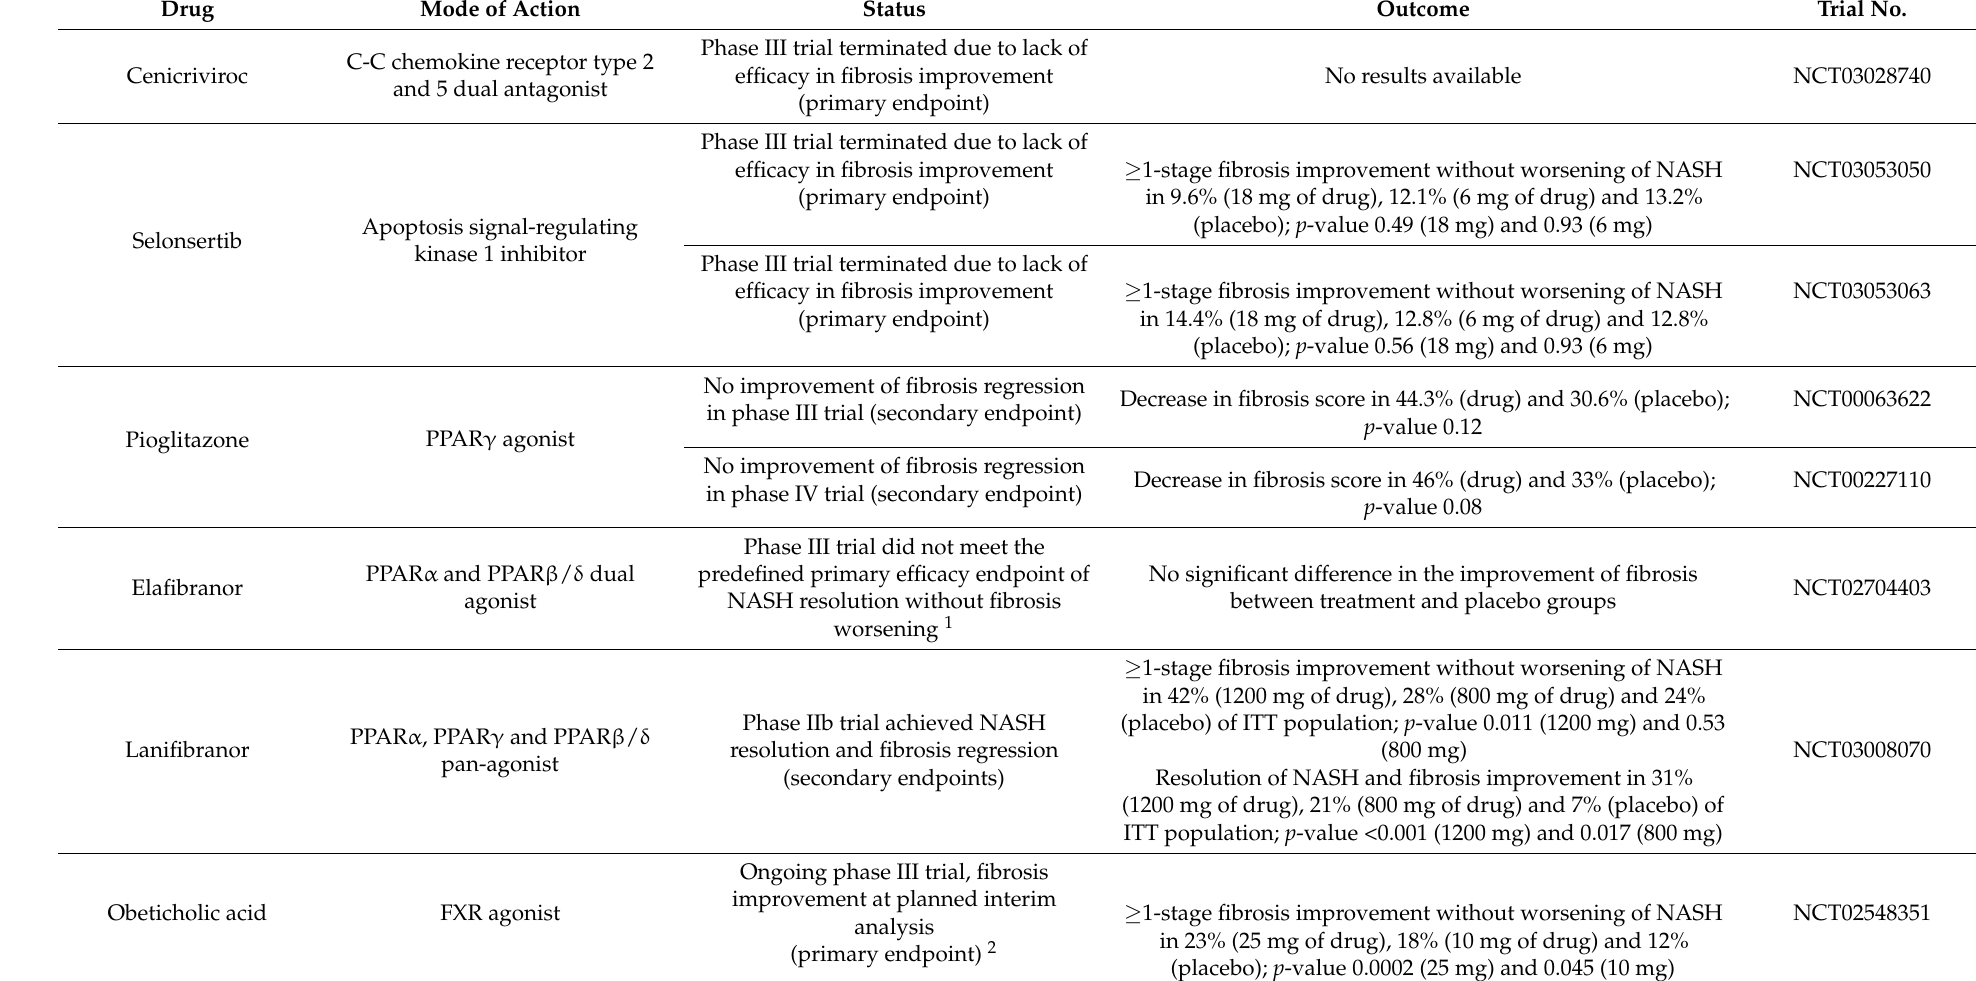
Table 1. Clinical trials of pharmacotherapies to improve NASH-associated liver